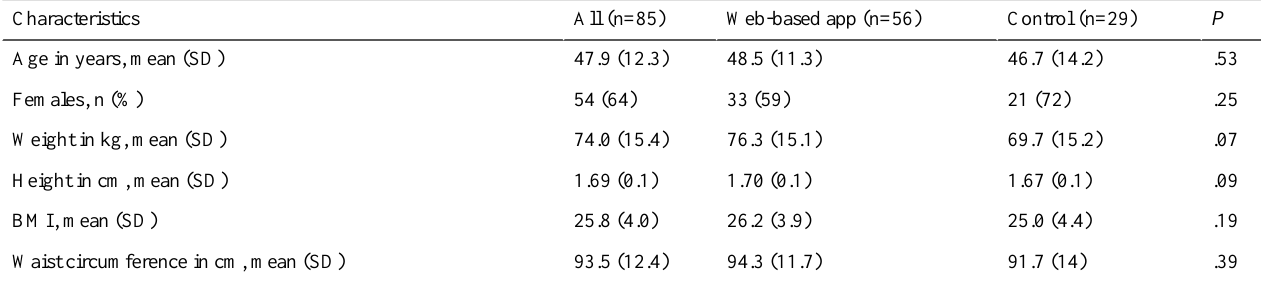
Table 1. Baseline characteristics of the RCT